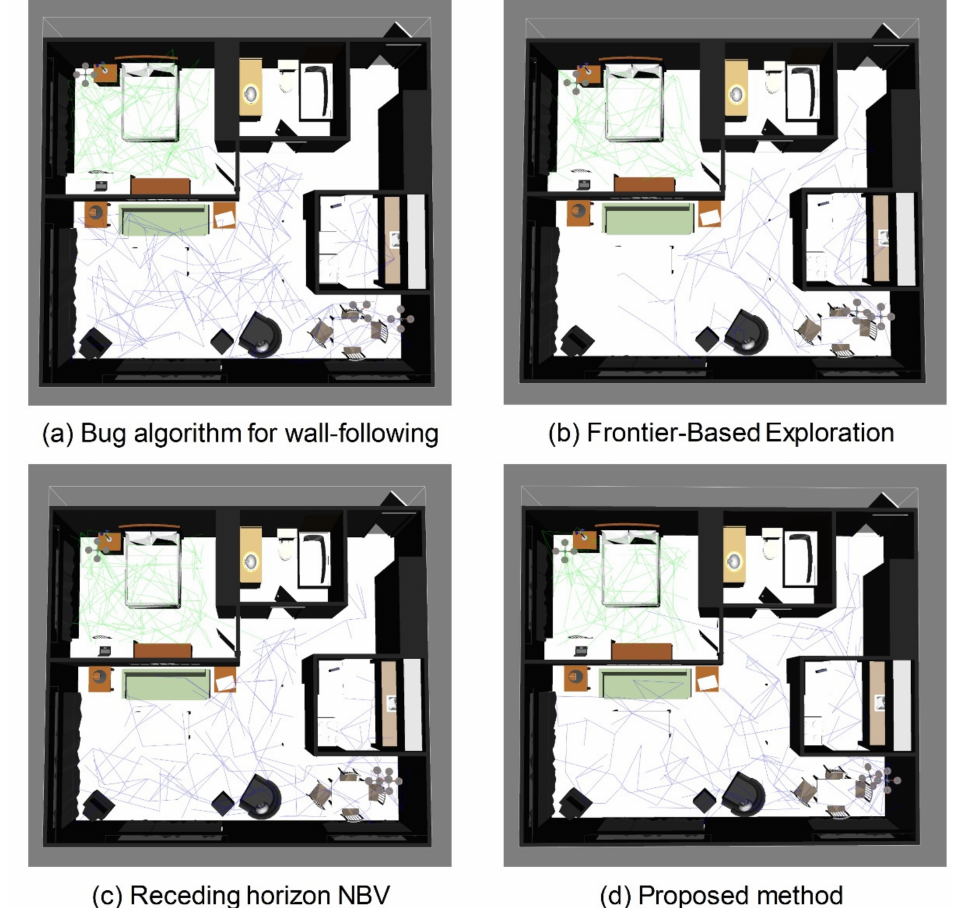
Figure 13. Exploration in apartment environment visualization by ( a ) Bug algorithm for wall- following, ( b ) Frontier-Based Exploration, ( c ) Receding horizon NBV and ( d ) proposed frontier and sample-based exploration algorithm when voxel resolution of 0.05